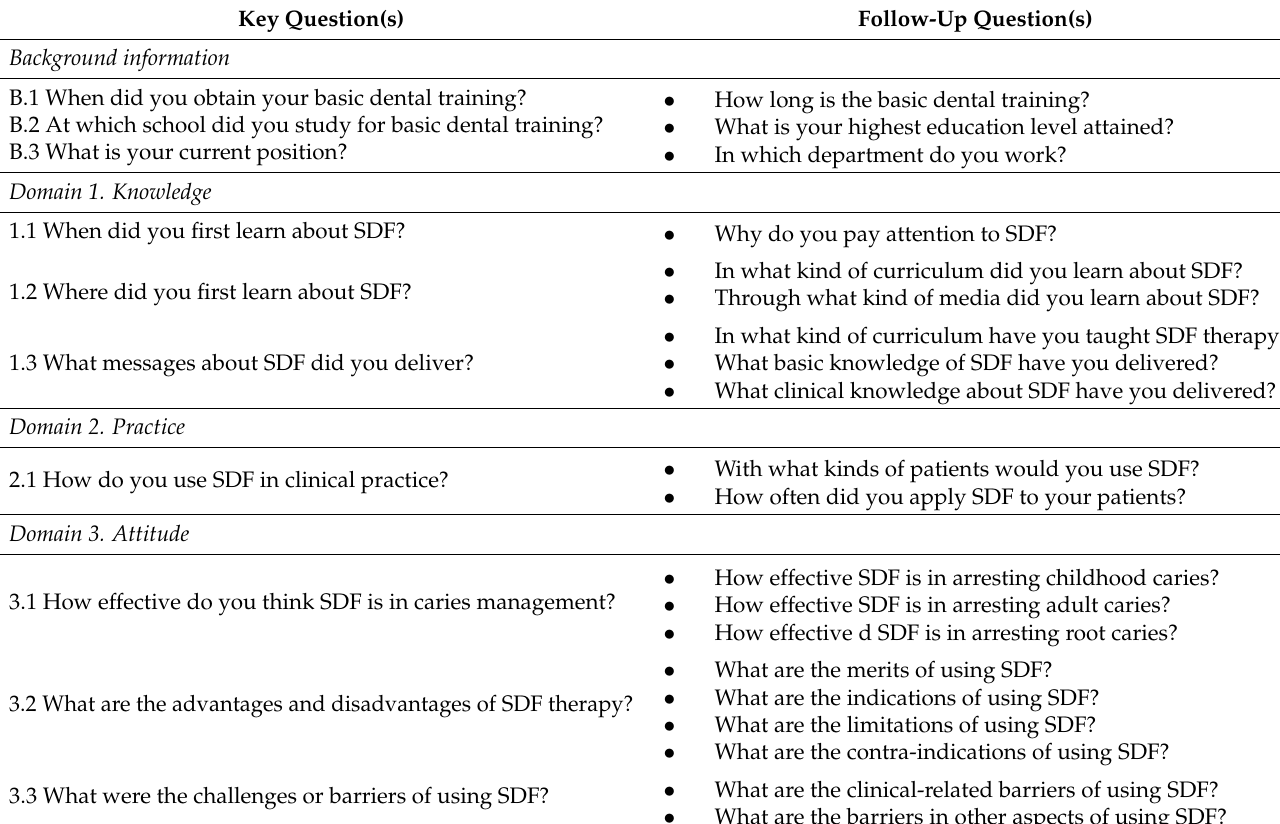
Table 2. The domains of and key and follow-up questions for the